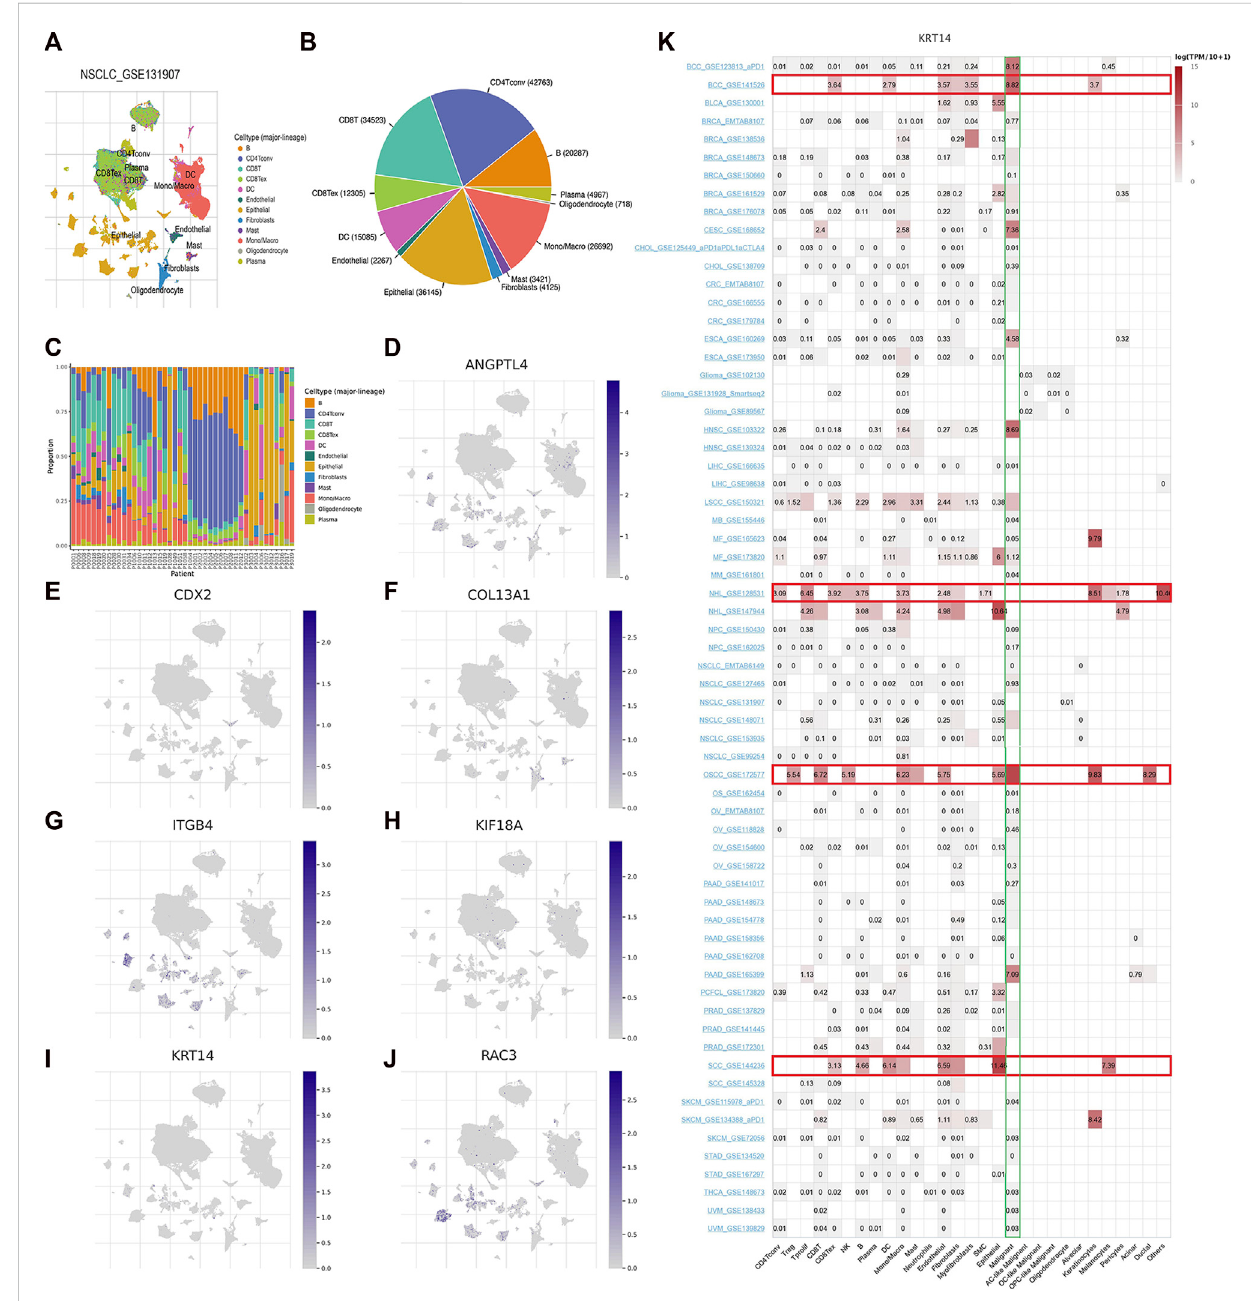
FIGURE 9 SevenARGsanalysesbasedonsingle-cellRNAsequencingdata. (A) AnnotationofcelltypesinGSE131907.Proportionofeachcelltypeinthedataset (B) and in each patient (C) . (D – J) Expression of ANGPTL4, CDX2, COL13A1, ITGB4, KIF18A, KRT14, and RAC3. (K) Expression of KRT14 in